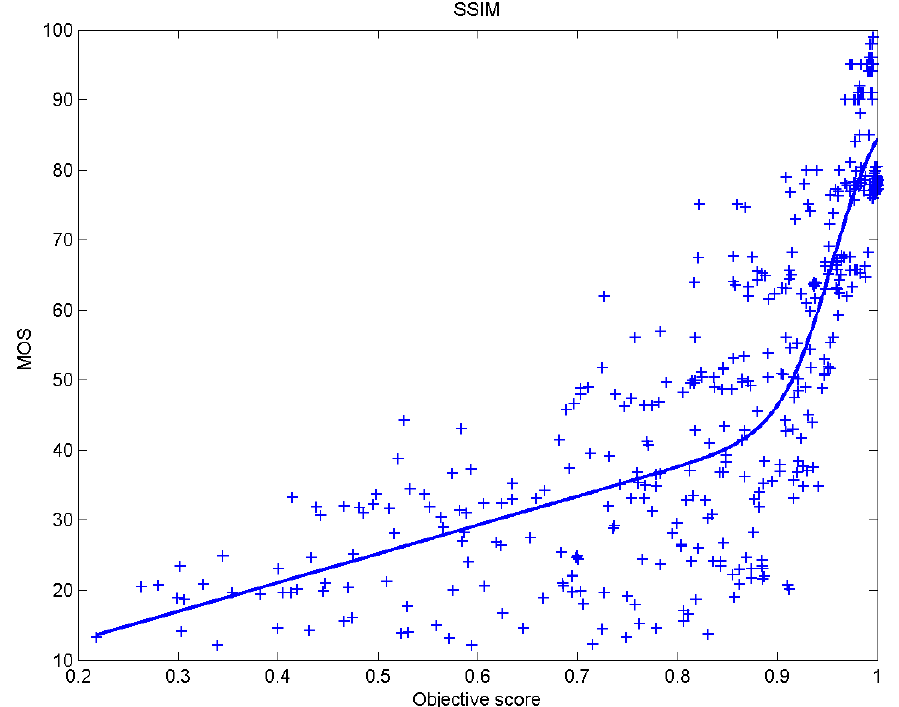
Figure 19. Scatter plots of the subjective scores (MOS) vs. SSIM.